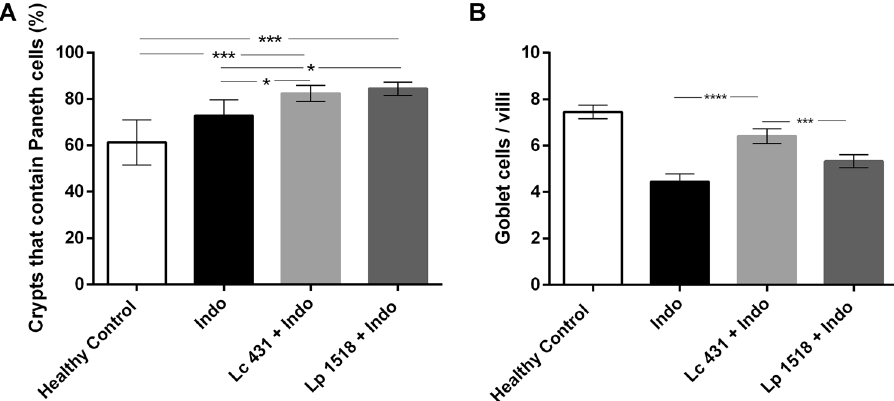
Figure 4. Mouse intestinal secretory cells in indomethacin-induced intestinal inflammation. Tissue sections of Balb/c mice orally supplemented with Lactobacillus casei CRL 431 (Lc 431), Lactobacillus paracasei CNCM I-1518 (Lp 1518), or water, for 7 and 5 days and receiving 2 indomethacin injections were stained with hematoxylin and eosin and examined by light microscopy. A blind histological test of the small intestine was performed by analyzing 5 slices of each organ and the percentages of ( A ) crypts with positive Paneth cells and ( B ) Goblet cells per villus were determined. Results were expressed as the number of Goblet cells per intestinal villus. The column bar shows a semi-quantitative evaluation for each group. Each bar represents the group mean ± S.E.M. Results are representative of three independent experiments. The line at the top of the bars indicates comparison between the two groups. * p < 0.05, ** p < 0.01, *** p < 0.001, **** p < 0.0001.